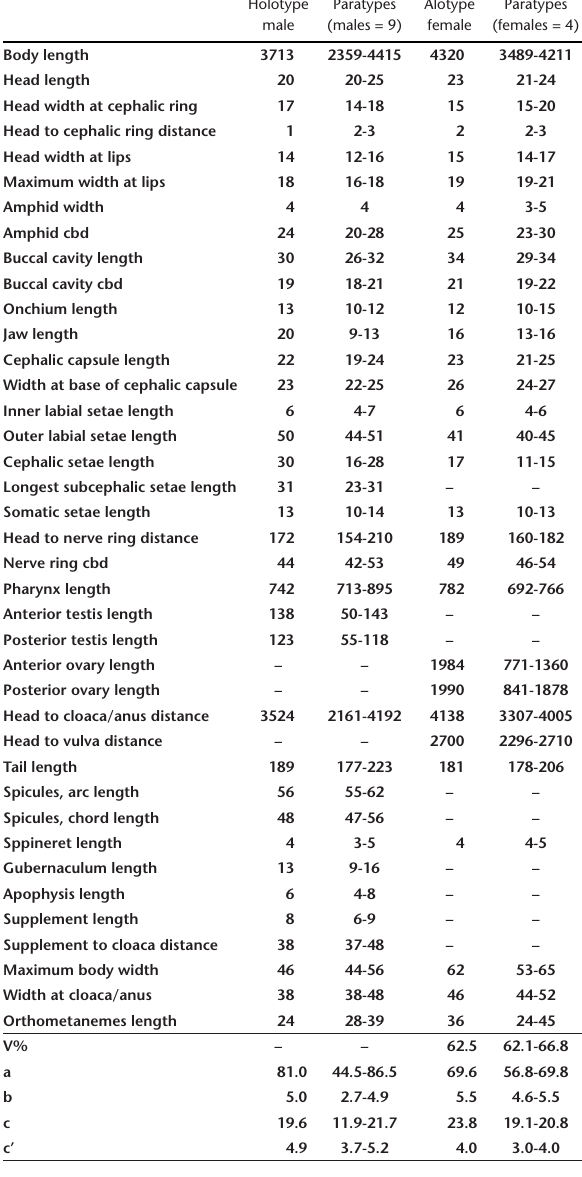
Table 1. Males and females measurements (µm) of Trileptium ribei- rensis sp. nov. (cbd) corresponding body diameter; (V%) position of vulva as a percentage of body length from the anterior end; (a) body length divided by maximum body diameter; (b) body length divided by pharyngeal length; (c) body length divided by tail length; (c’) tail length divided by body width at the anus or cloacal